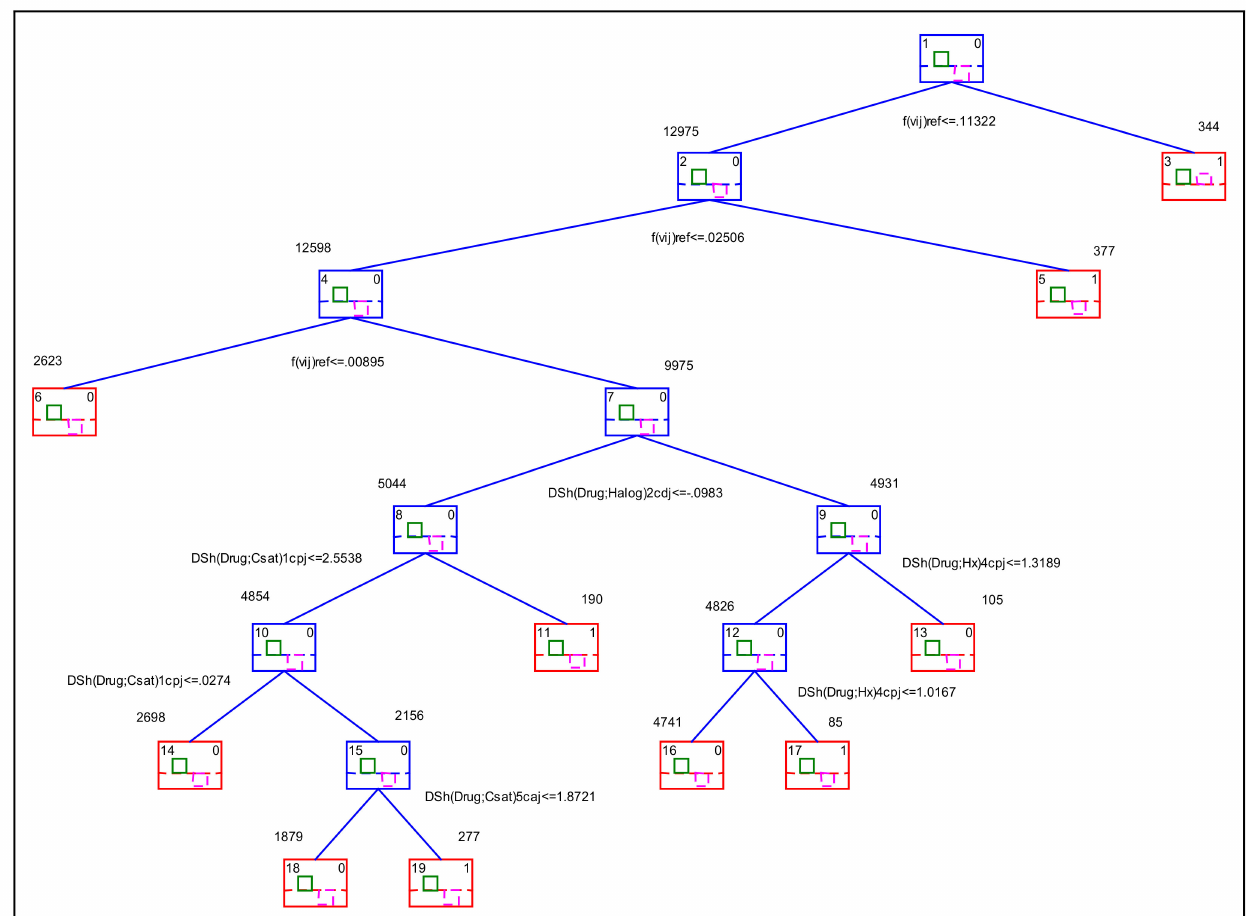
Figure 3. IFPTML-CTUS model decision